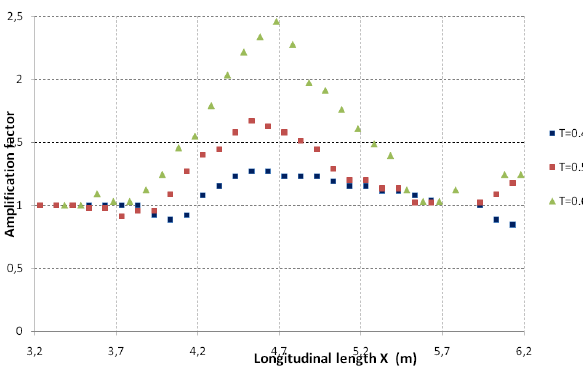
Fig. 3. Amplification factor along x-axis in the centre of the basin. Fig. 3: Amplification factor along x-axis in the centre of the basin